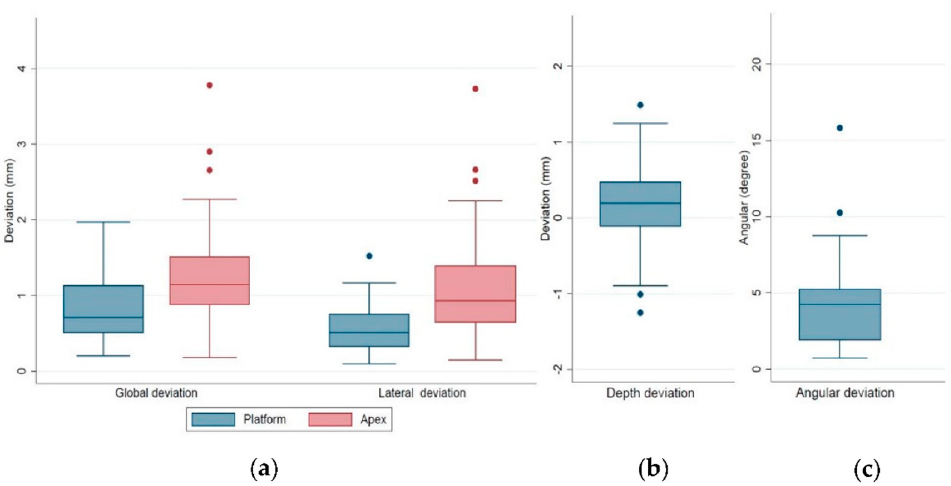
Figure 8. Box plots of the ( a ) global and lateral deviations at implant platform/apex, ( b ) depth deviation, and ( c ) angular deviation.